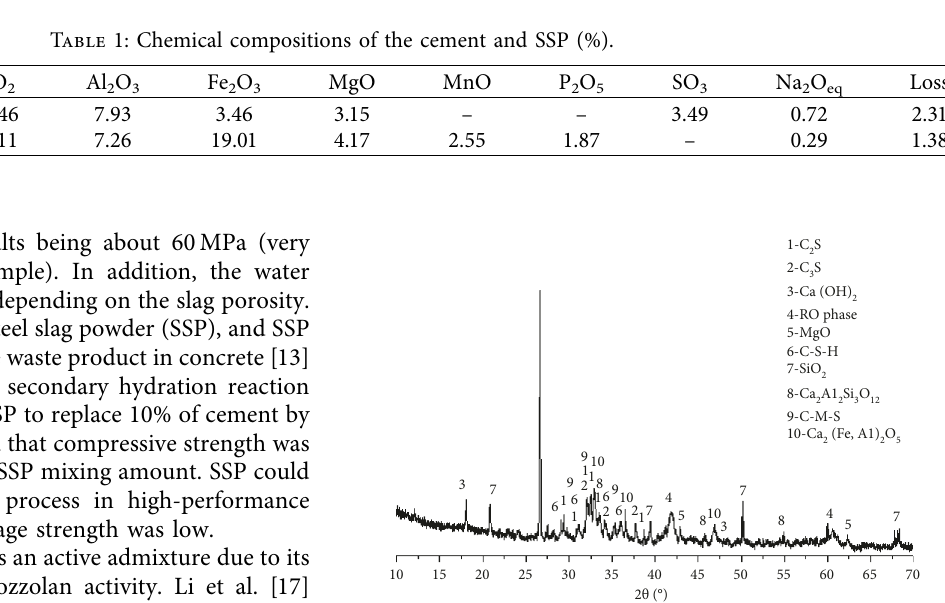
Figure 1: The XRD pattern of the steel